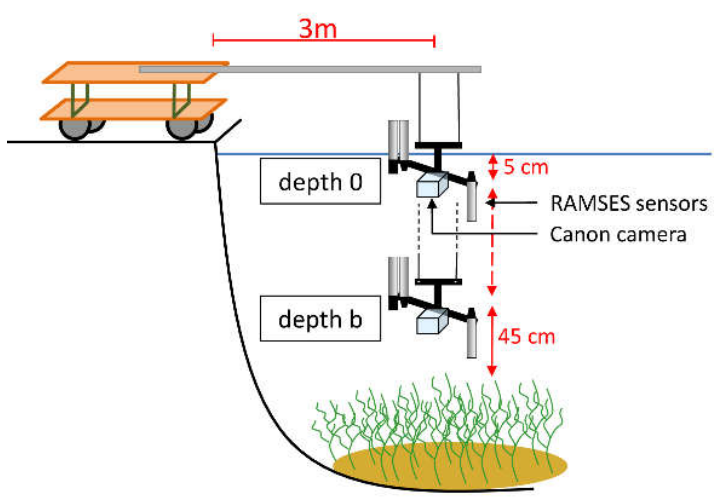
Figure 3. Measurement setup of in‐situ data collection (modified from Wolf et al. [13]).